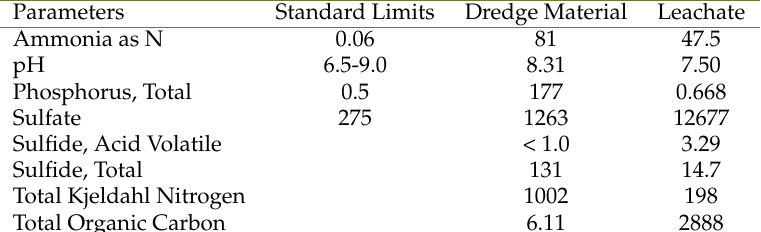
Table 4. Inorganic and Organic parameters for the dredged material and leachate (ppm) Parameters